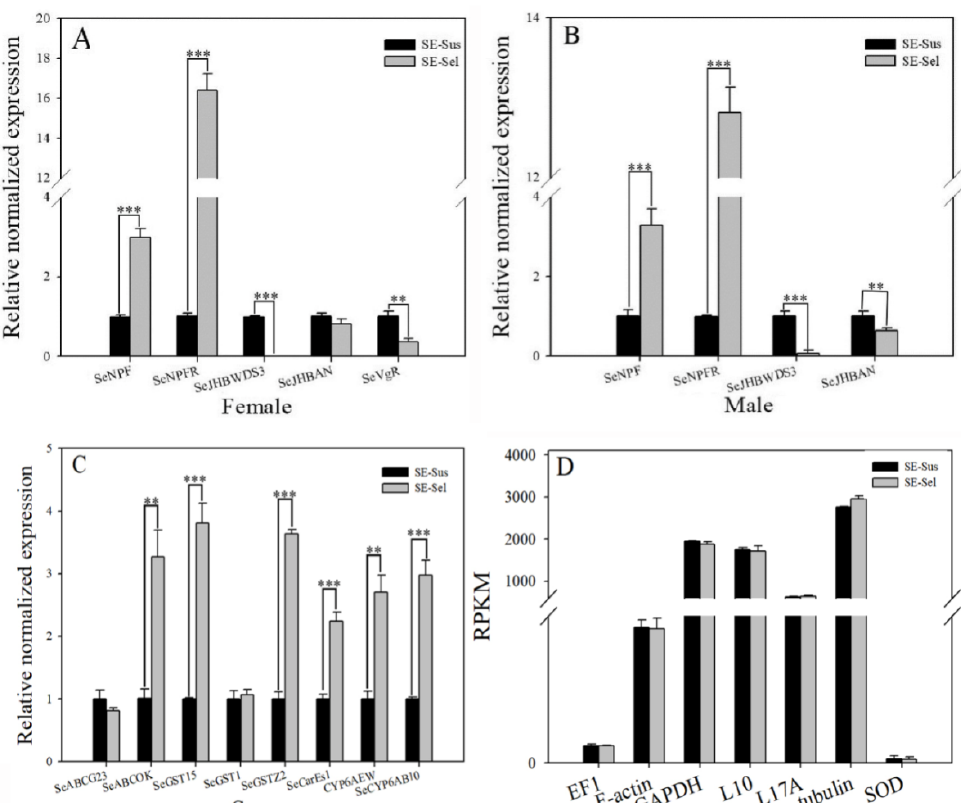
Figure 5. Gene expression pattern of the candidate genes in the SE-Sus and SE-Sel strains. ( A ) The relative normalized expression of SeNPF , SeNPFR , SeJHBAN , SeJHBWDS3 , and SeVgR of female adult in the SE-Sus and SE-Sel strains; ( B ) The relative normalized expression of SeNPF , SeNPFR , SeJHBAN , and SeJHBWDS3 of male adult; ( C ) The relative normalized expression of detoxification metabolism genes of adult; ( D ) The expression level (RPKM) of reference gene of adult. Different numbers of asterisks indicate significant differences at different levels (* means p < 0.05, ** means p < 0.01, *** means p < 0.001).